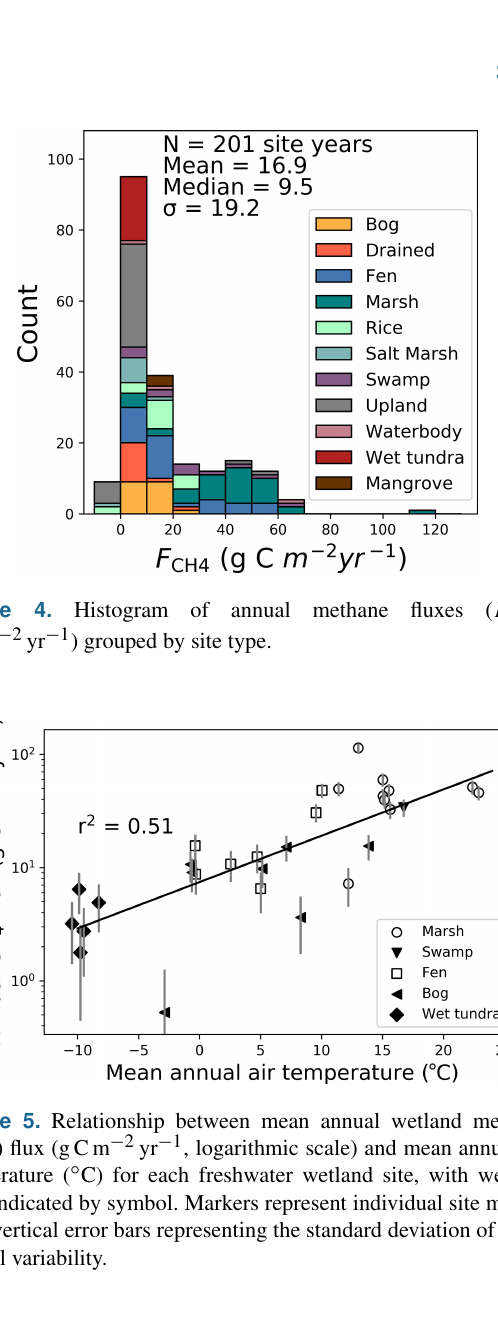
Figure 5. Relationship between mean annual wetland methane (CH 4 ) flux (gCm − 2 yr − 1 , logarithmic scale) and mean annual air temperature ( ◦ C) for each freshwater wetland site, with wetland type indicated by symbol. Markers represent individual site means, with vertical error bars representing the standard deviation of inter- annual